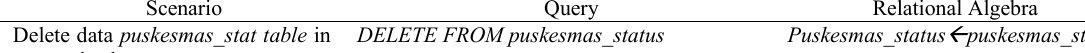
TABLE 9 SCENARIOS AND DETERMINATION OF TRANS QUERY OF ENDEMIC